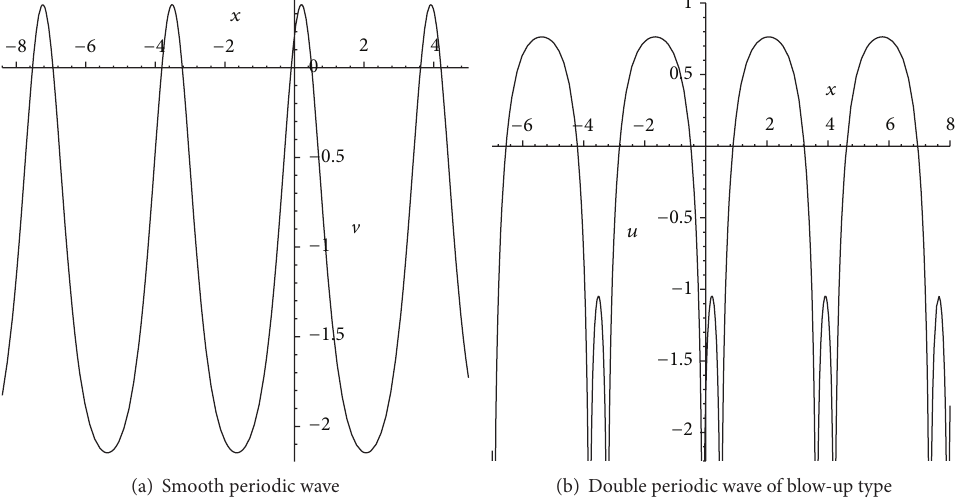
Figure 4: The phase portraits of solutions (67) and (68) for ℎ = 8 , 𝛼 = 2.5 , 𝛽 = −2.5 , 𝑐 = 2 , 𝑡 = 0.1